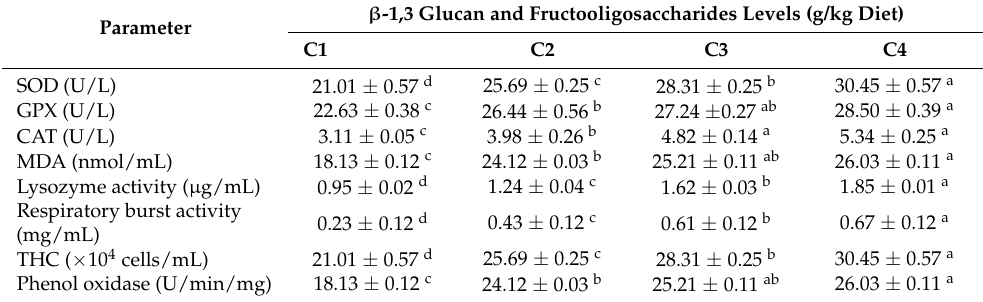
Table 4. Antioxidants and non-specific immune response of white shrimp, Litopenaeus vannamei , fed different levels of β -1,3 glucan and fructooligosaccharides for 75 days. Parameter